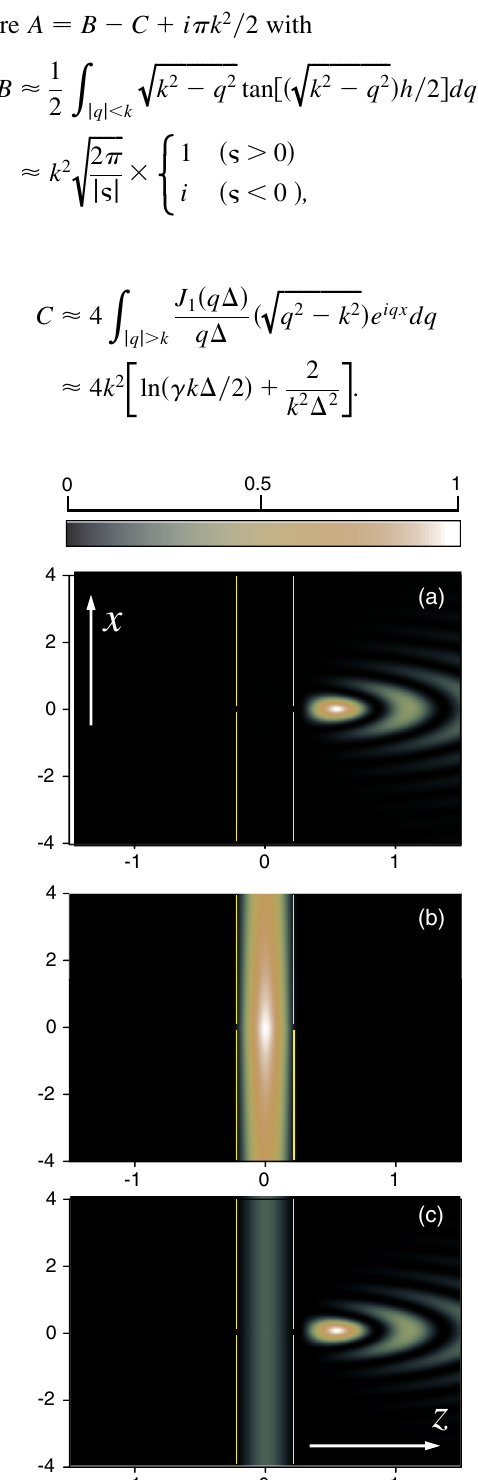
FIG. 2. Contour plots of j E y ð x; z Þj 2 for (cid:2) =(cid:1) ¼ 0 : 02 ( & R (cid:4) 10 (cid:6) 4 ), normalized to its largest value. Results are for h ¼ ð (cid:3) (cid:6) & Þ =k with (a) & ¼ 2 (cid:12) 10 2 & (c) & ¼ 2 (cid:12) 10 (cid:6) 6 & R . The perfectly conducting screens are in- dicated by yellow lines. Cylindrical waves travel from right to left. Lengths are in units of (cid:1)